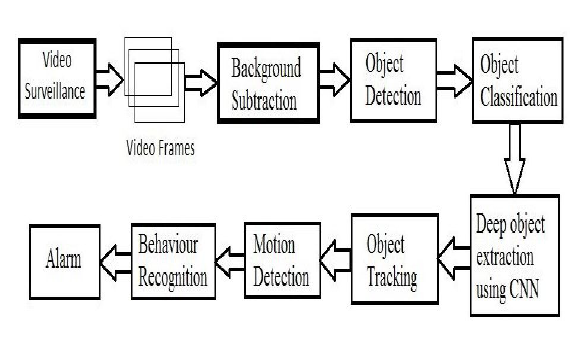
Figure 1. Proposed